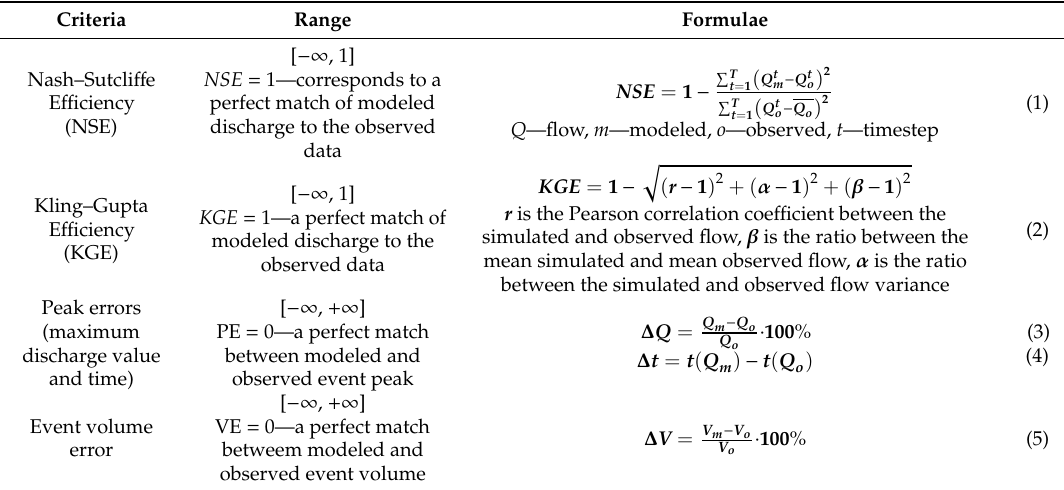
Table 2. Model performance